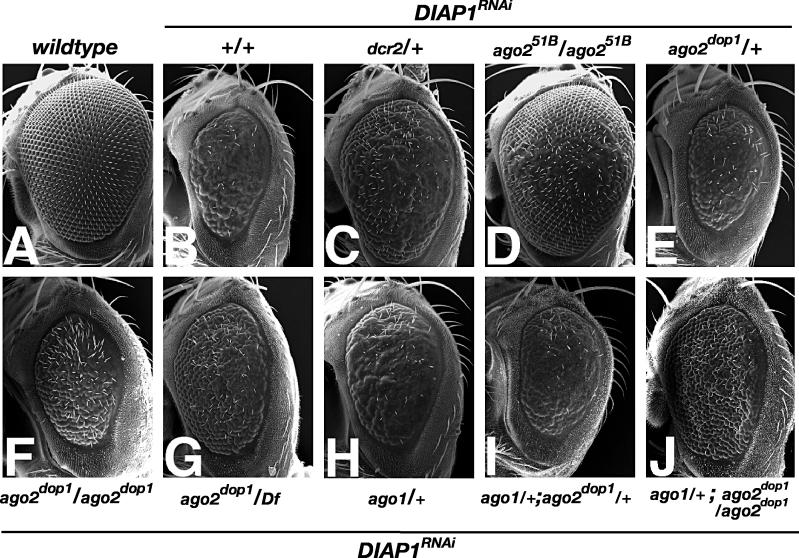
Requirement of ago2 and ago1 for siRNA-Mediated RNAiEffects of mutations on siRNA-mediated RNAi were assayed using a UAS construct that reduces the function of the cell death inhibitor DIAP1 by expression of dsRNA (DIAP1RNAi: GMR::Gal4,UAS::DIAP1RNAi) [38]. DIAP1RNAi in the compound eye leads to the loss of cells and reduces the normal size of the eye. Scanning EM micrographs of compound eyes of 2- to 4-d-old females of the following genotypes are indicated: (A) wild-type compound eye; (B) GMR::Gal4, UAS::DIAP1RNAi/CyO; (C) GMR::Gal4, UAS::DIAP1RNAi/dcr-2L811fsX; (D) GMR::Gal4, UAS::DIAP1RNAi/CyO; ago251B/ago251B; (E) GMR::Gal4, UAS::DIAP1RNAi/CyO; ago2dop1/TM6; (F) GMR::Gal4, UAS::DIAP1RNAi/CyO; ago2dop1/ago2dop1; (G) GMR::Gal4, UAS::DIAP1RNAi; ago2dop1/Df(3L)XG9; (H) GMR::Gal4, UAS::DIAP1RNAi/ago1K08121; (I) GMR::Gal4, UAS::DIAP1RNA/ago1K08121; ago2dop1/TM6; and (J) GMR::Gal4, UAS::DIAP1RNAi/ago1K08121; ago2dop1/ago2dop1.